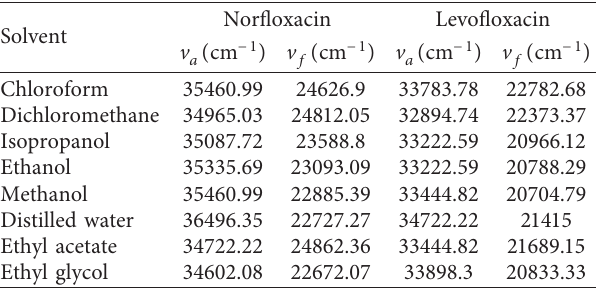
Figure 3: (a) UV/Vis absorption spectra and (b) emission spectra of NRF in solvents with different solvent polarities. Table 2: Peaks of the absorption and emission spectra of LVF and NRF in solvents with different